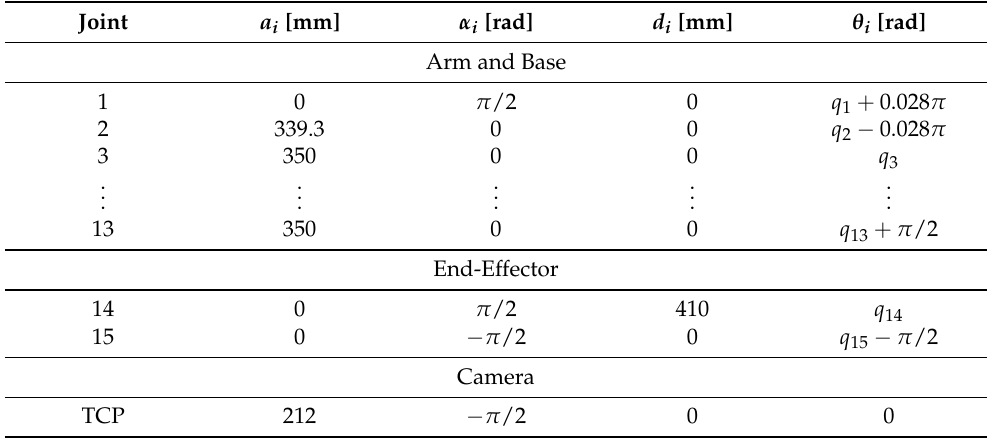
Table 1. DH parameters for SLIM.